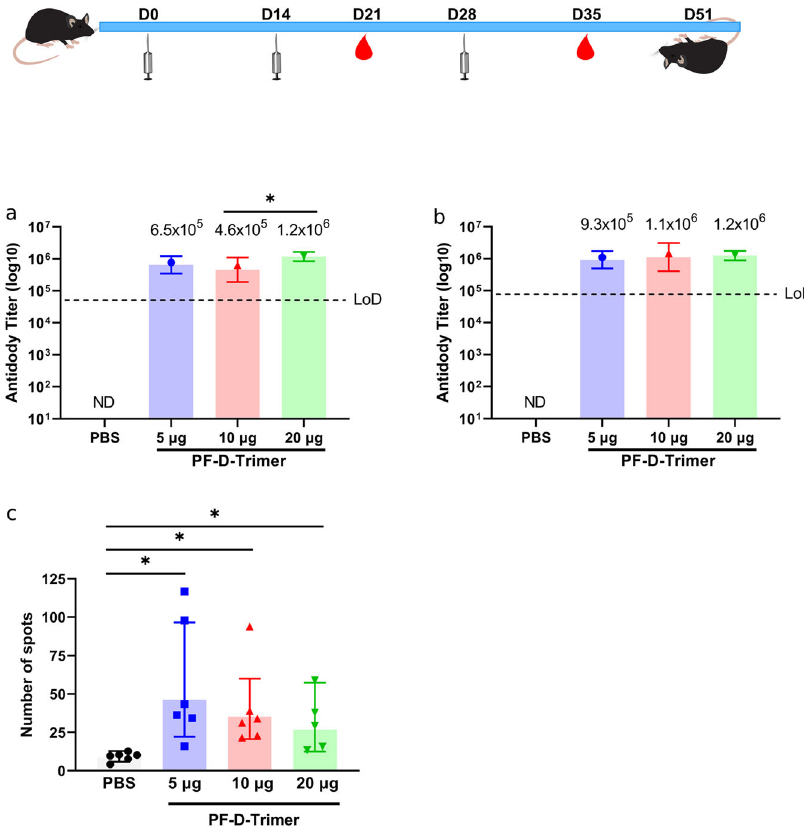
Fig. 2 Immunogenicity of PF-D-Trimer in mice. C57BL/6 mice were immunized with three different doses of PF-D-Trimer formulated with alum plus CpG 1018, as indicated in the top panel and described in “ Methods ” . Sera were collected and the immune responses were analyzed one week after the second (Day 21) and the third (Day 35) injections. a PF-D-Trimer binding antibody ELISA titers at Day 21. b PF-D-Trimer binding antibody ELISA titers at Day 35. c IFN- γ + phenotype by ELISpot after stimulation by S protein. Points represent individual animal; bars indicate geometric mean titers (GMT) responses (with geometric standard deviation) for antibody assays and geometric mean counts (GMC) responses (with geometric standard deviation) for ELISpot. * p ≤ 0.05, *** p ≤ 0.001, **** p ≤ 0.0001. ● 5 μ g group, ▲ 10 μ g group, ▼ 20 μ g group. Dotted lines indicate the limits of detection, LOD; a 4 × 10 4 b 8 × 10 4 . ND = the antibodies were not detected. Ordinary one-way ANOVA with Dunnett ’ s multiple comparison was used to analyze the differences among